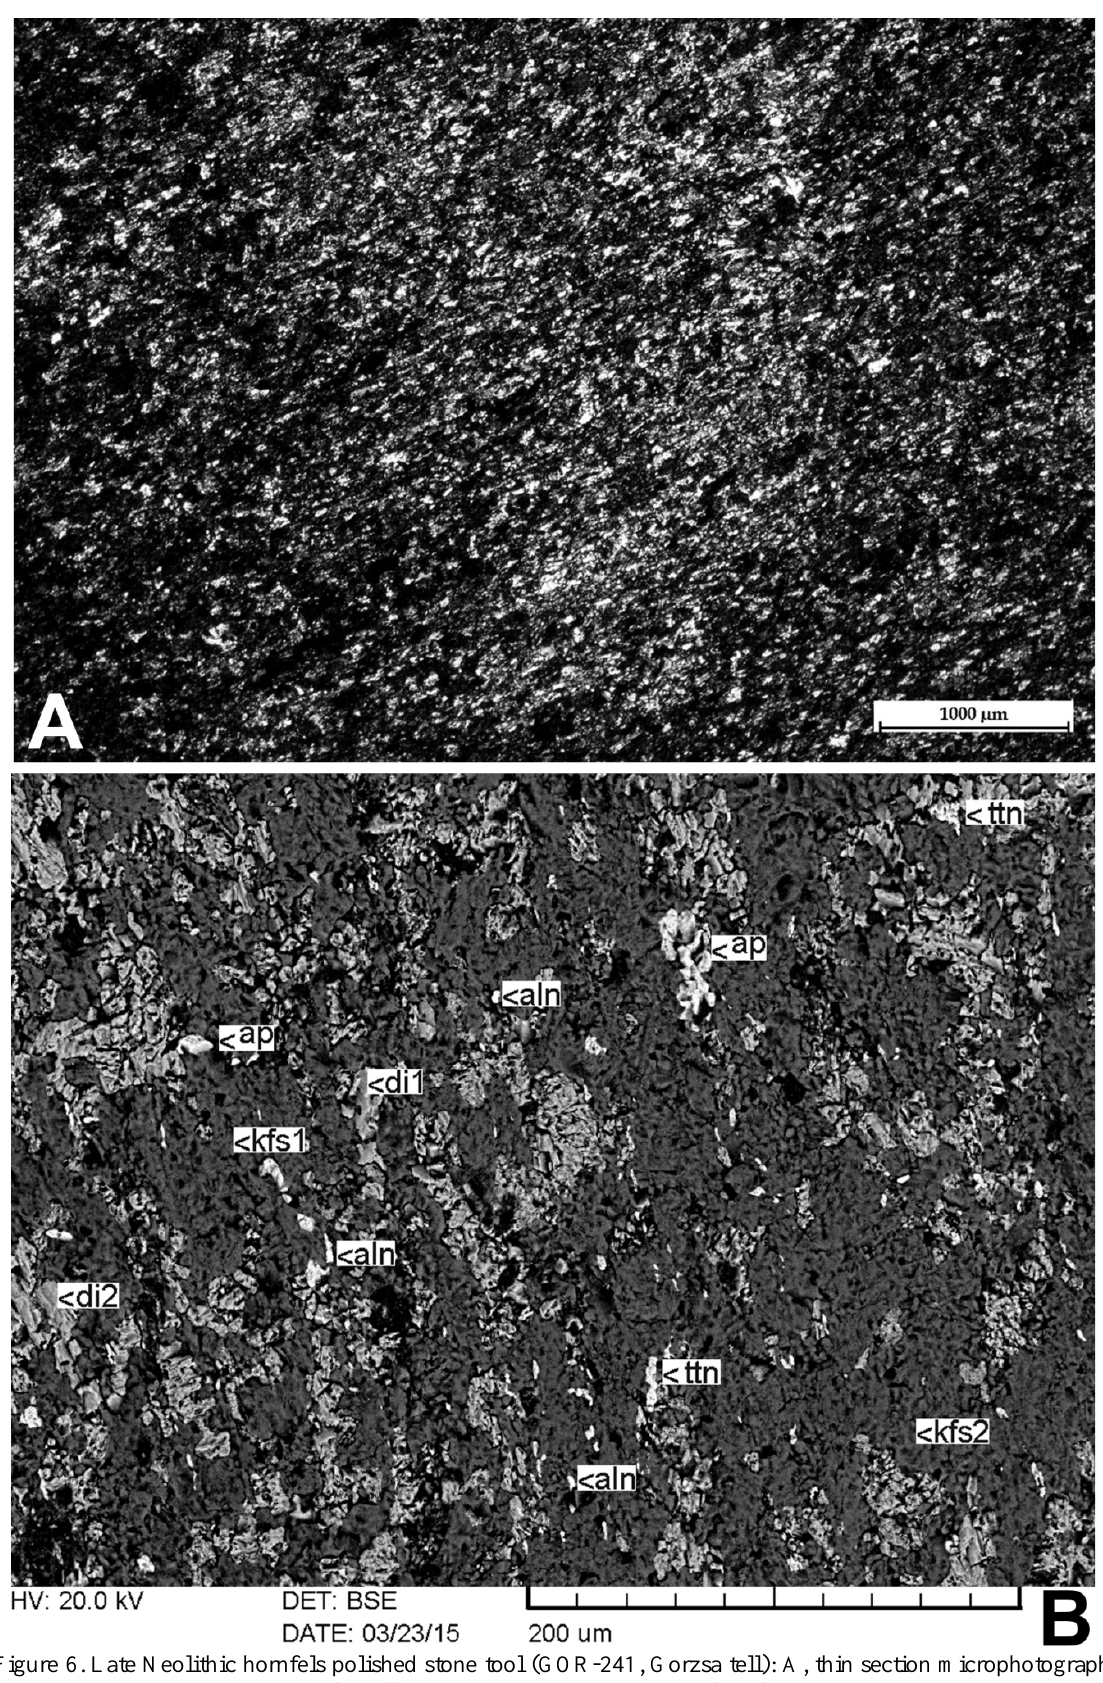
Figure 6. Late Neolithic hornfels polished stone tool (GOR-241, Gorzsa tell): A, thin section microphotographs (modified from Szakmány et al . (2016)); B, Back-Scattered Electron (BSE) image of the same sample: aln = allanite, ap = apatite, di1 & di2 = diopside, kfs1 & kfs2 = K-feldspar, ttn =